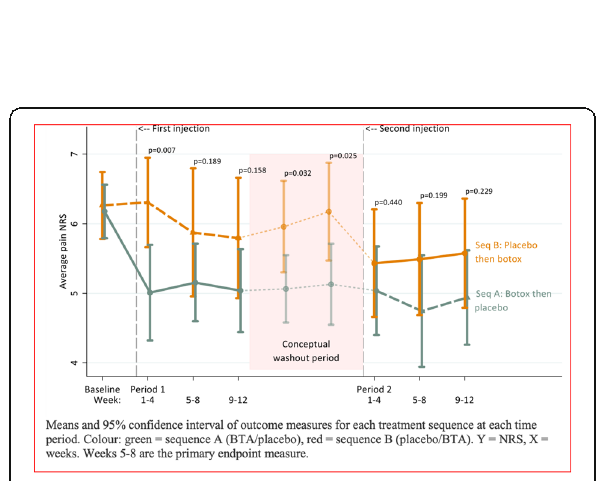
Fig. 3 (abstract P283). Primary outcome demonstrated by treatment sequence A and